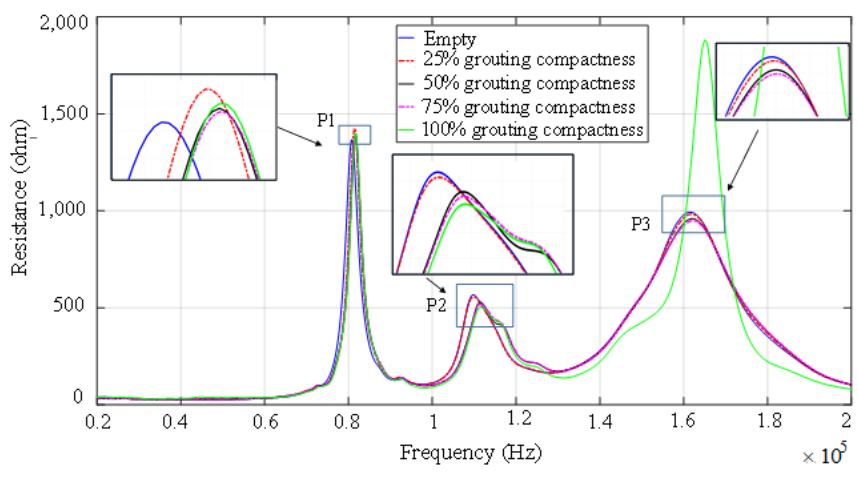
Figure 8. The measured impedance signature of PZTs at different grouting compactness levels.